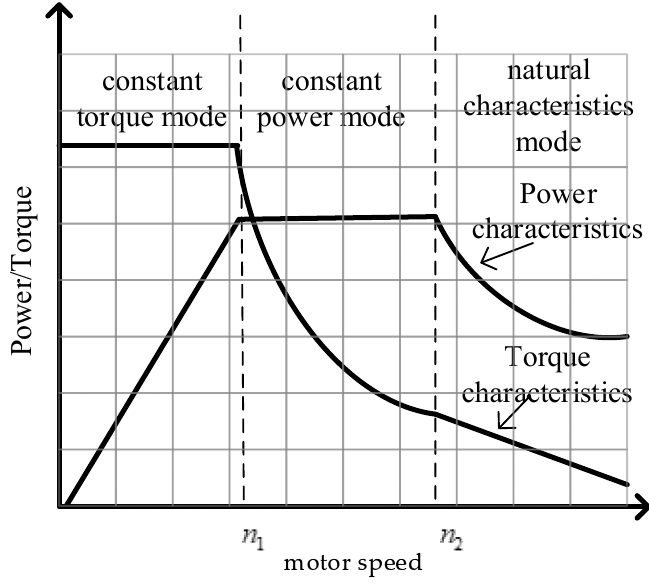
Figure 2. Motor traction characteristic model.